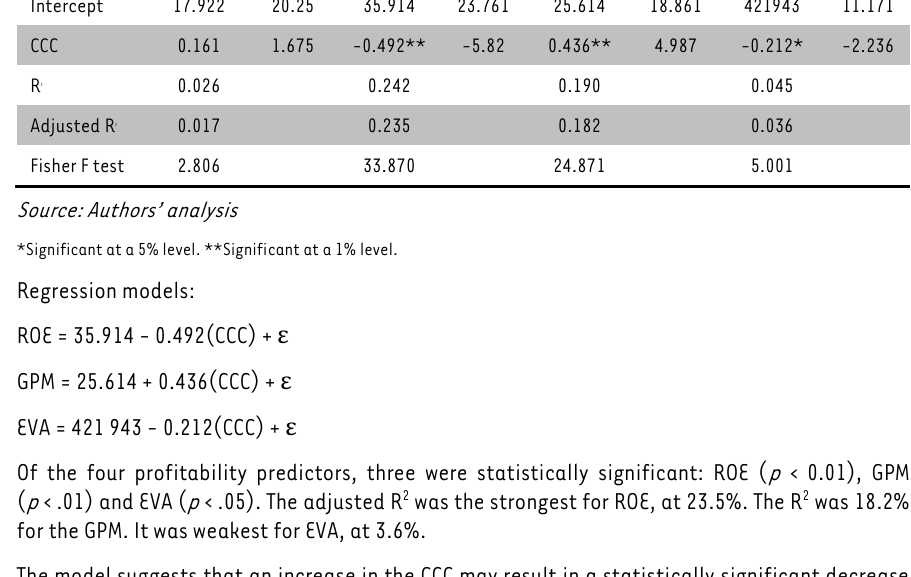
TABLE 3: Multiple regression analyses between the CCC and profitability ROA ROE GPM EVA Estimate t-value Estimate t-value Estimate t-value Estimate t-value